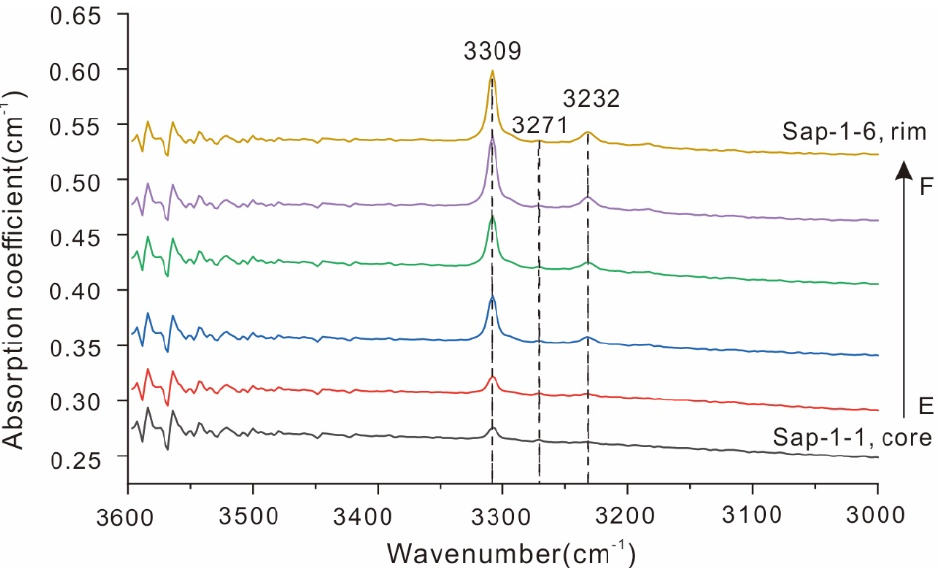
Figure 7. The FTIR patterns of the deep-blue core and yellowish-brown rim from the Penglai sapphire (sample Sap-1). The plot locations over profile EF are shown in Figure 4.